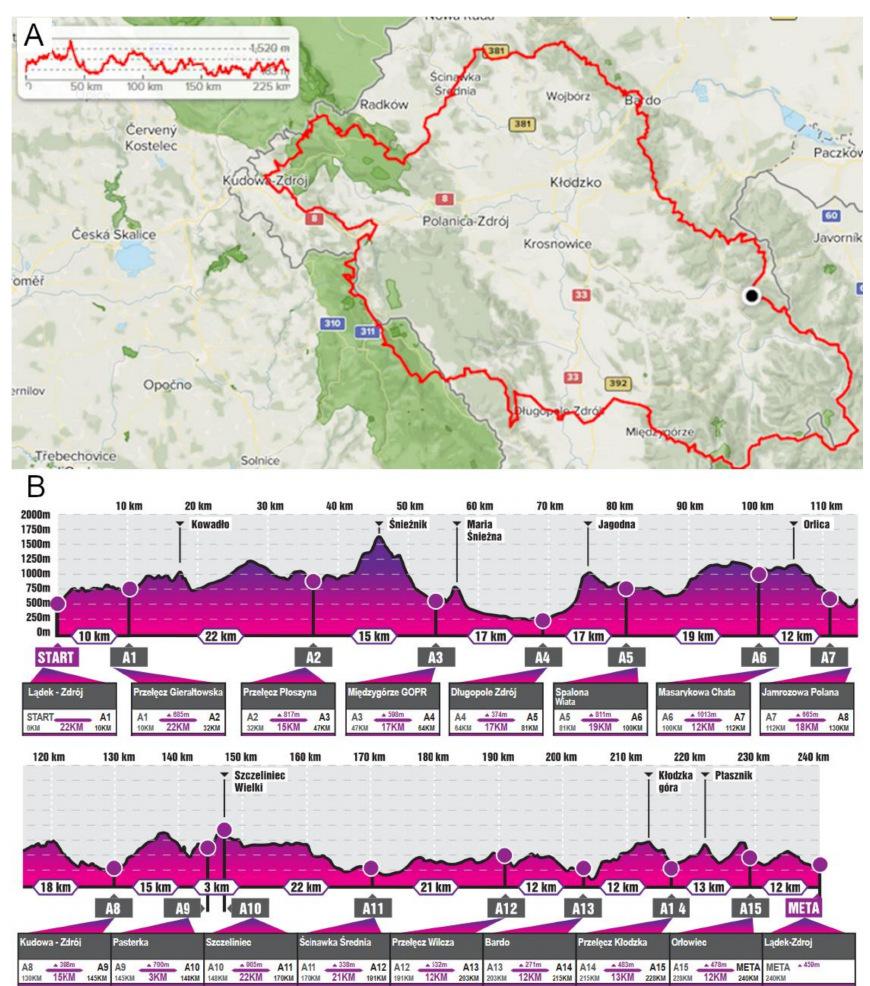
Figure 1. Ultra-marathon track characteristics of the Lower Silesian Mountain Run Festival 2018, L ˛adek Zdr ó j. The entire track ( A ) and select track parts and distances ( B ) are shown (Mountain Marathons